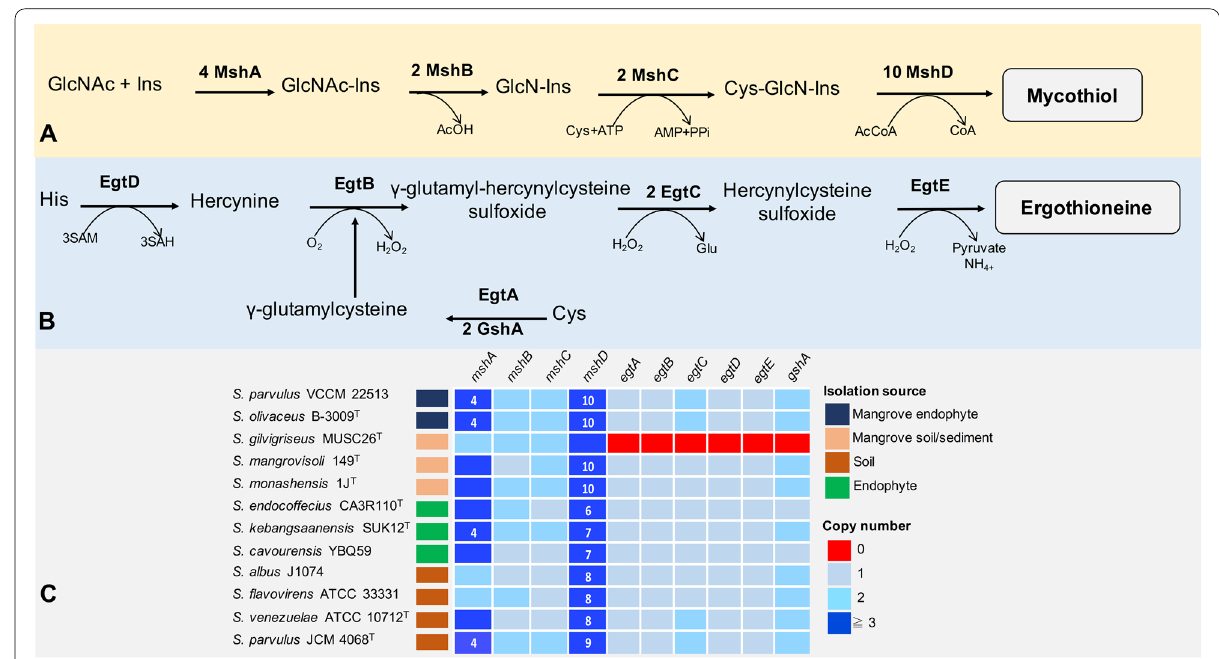
Fig. 3 The biosynthesis of mycothiol and ergothioneine in S. parvulus VCCM 22513. The proposed biosynthetic pathways of mycothiol ( A ) and ergothioneine ( B ) in S. parvulus VCCM 22513. Abbreviations: GlcNAc, N ‑acetyl glucosamine; Ins, myo ‑inositol; His, histidine; Cys, cysteine. C Comparative analysis of genetic determinants dedicating to mycothiol and ergothioneine biosynthesis between mangrove endophytic S. parvulus VCCM 22513 and 11